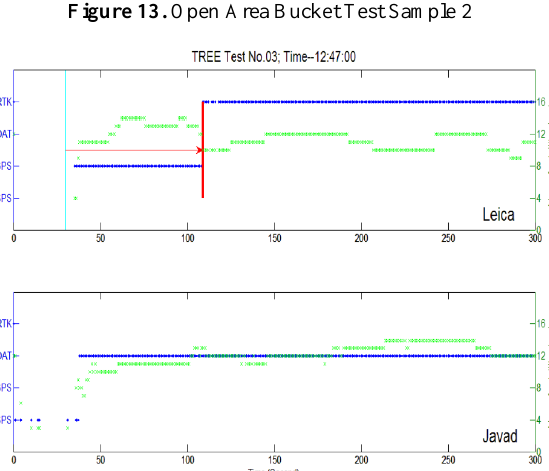
Figure 13. Open Area Bucket Test Sample 2